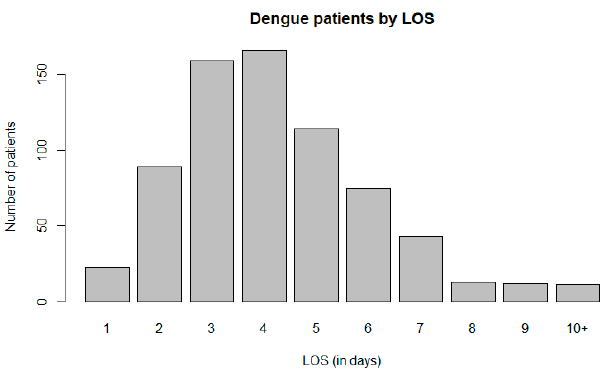
Figure 1. Dengue patients in Wahidin hospital by the length of stay (LOS).